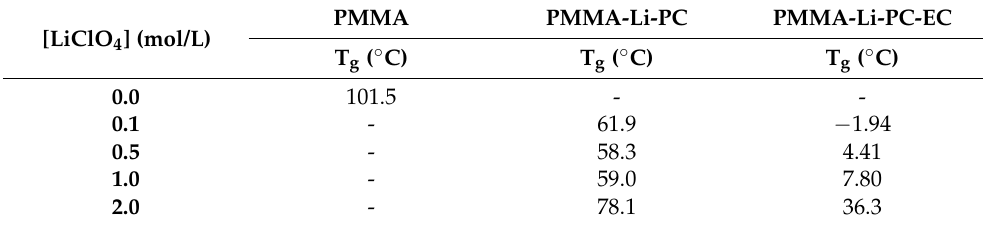
Table 3. Glass transition temperatures were obtained from the DSC studies performed on PMMA and PMMA-Li-PC, and PMMA-Li-PC-EC polymeric gel electrolytes at different salt concentrations: 0.1 M, 0.5 M, 1 M and 2